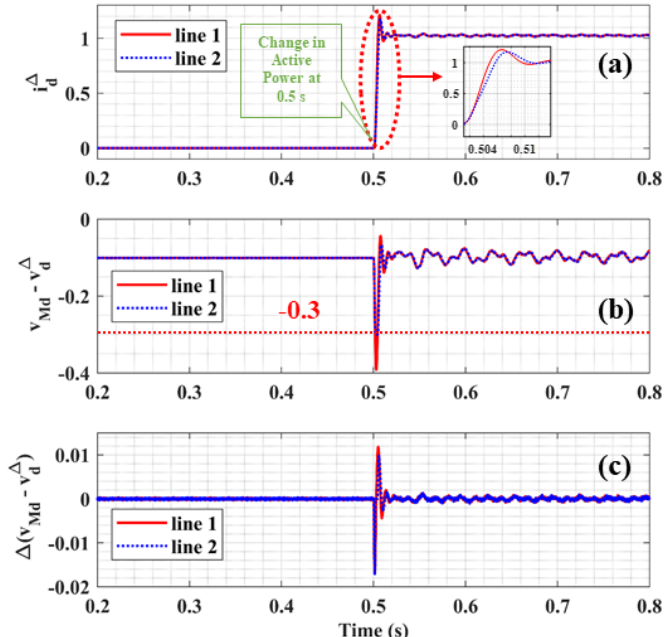
Figure 21. Effect of constraints on ( a ) i ∆ Unconstrained, line 2: